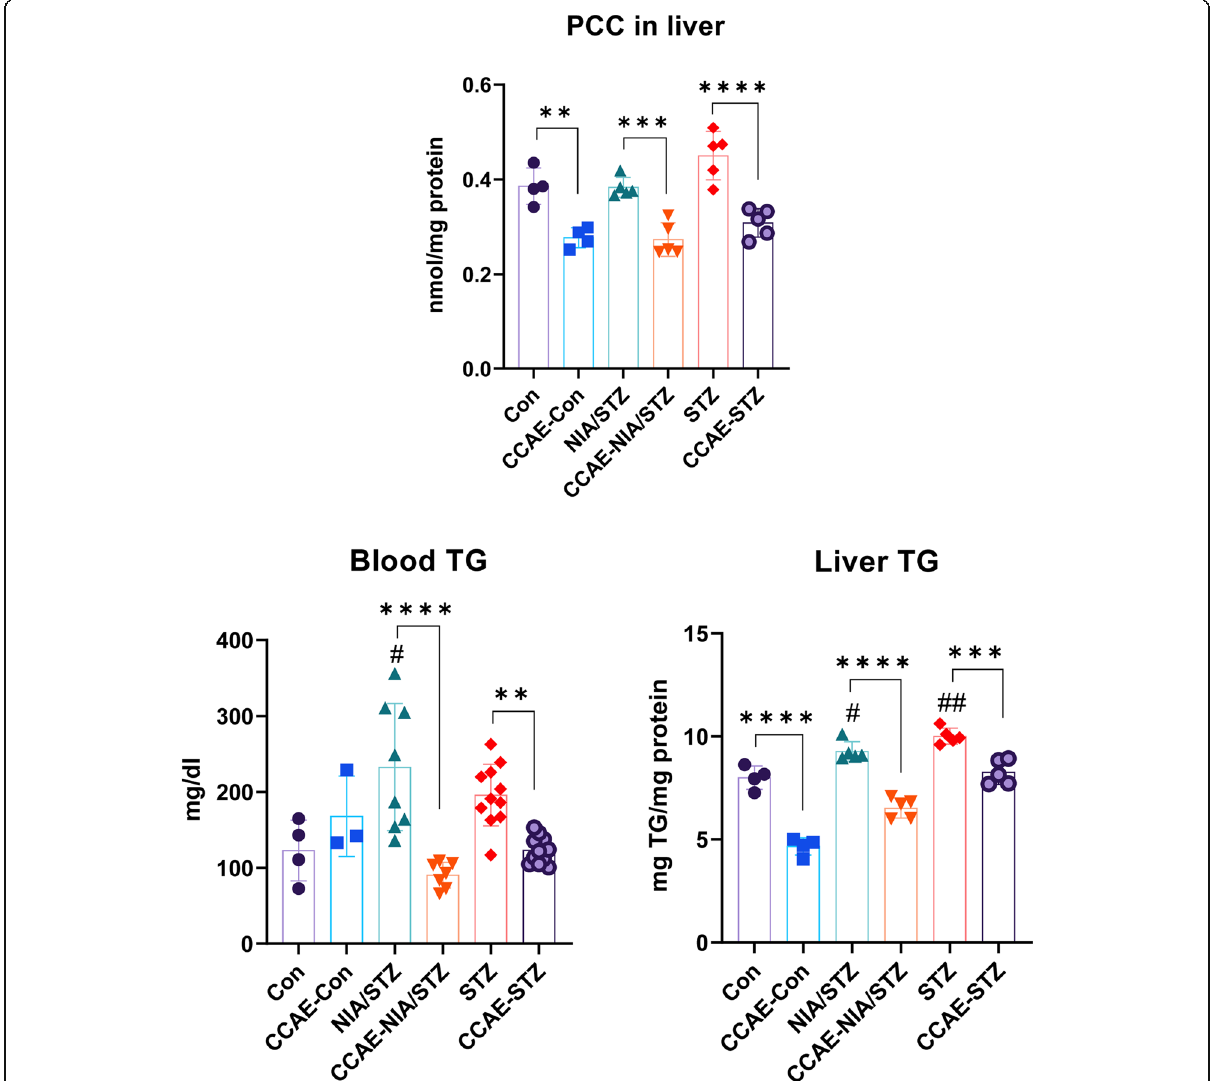
Fig. 6 Effect of CCAE on hepatic protein carbonylation and triglyceride levels. We observed increased levels of PCC (LT2D and ET2D vs. Con, p = 0.73 and p = 0.19, respectively) and TG in the liver tissue of both diabetic groups compared to Con. Treatment with CCAE led to a significant reduction of both variables in all treated groups compared to their untreated controls. Con: nondiabetic control, CCAE-Con: nondiabetic control treated with CCAE, NIA/STZ: early-stage diabetic group, CCAE-NIA/STZ: the early-stage diabetic group treated with CCAE, STZ: late-stage diabetic group, CCAE-STZ: the late-stage diabetic group treated with CCAE. we have expressed the values as mean ± SEM. *, p = 0.016; **, p = 0.008, † , p = 0.029. #, p < 0.05 and ##, p < 0.01 show significant differences between the diabetic group (STZ or NIA/STZ, respectively) versus